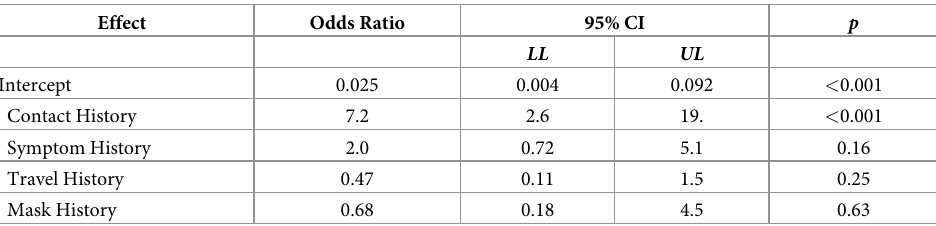
Table 3. Multivariable